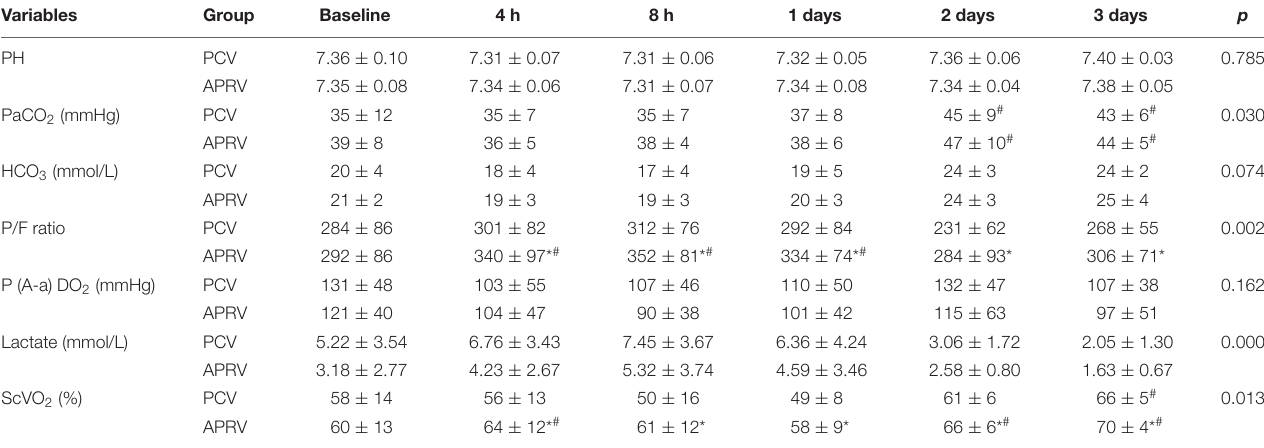
TABLE 4 | Arterial Blood gasses analysis. Variables Group